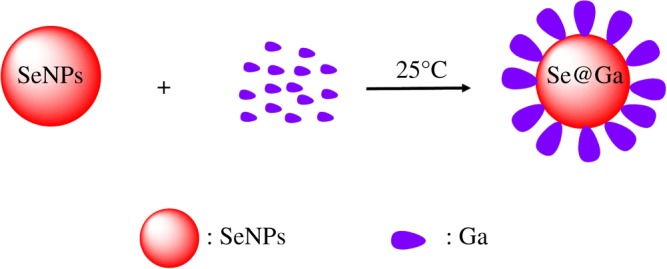
Synthetic route towards Se@Ga.